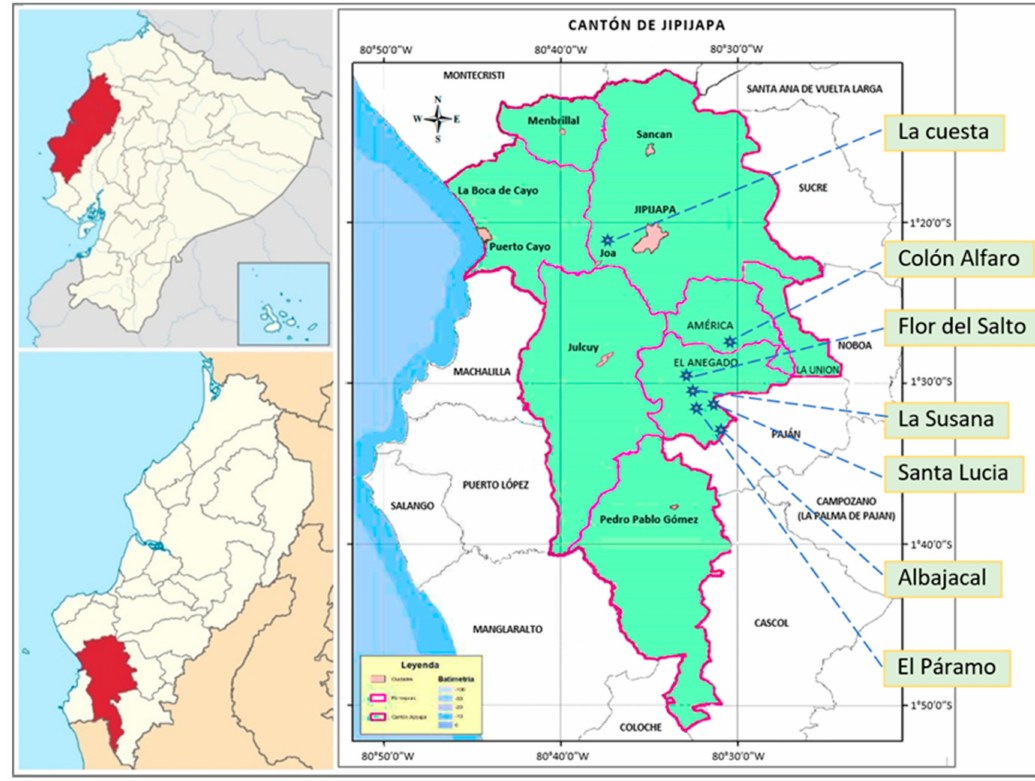
Figure 1. Geographic location of sampling